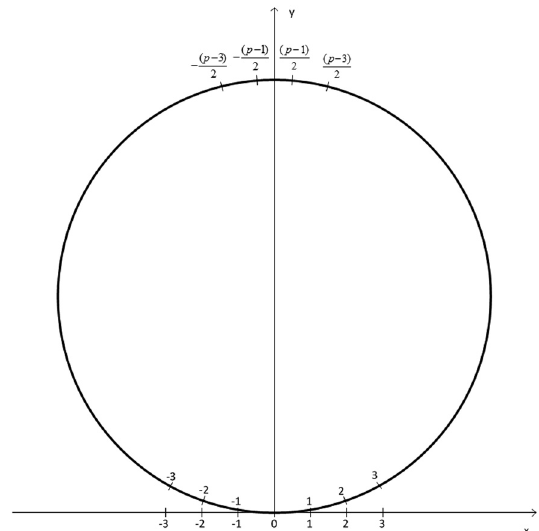
Figure 1: Relation between R p and Z